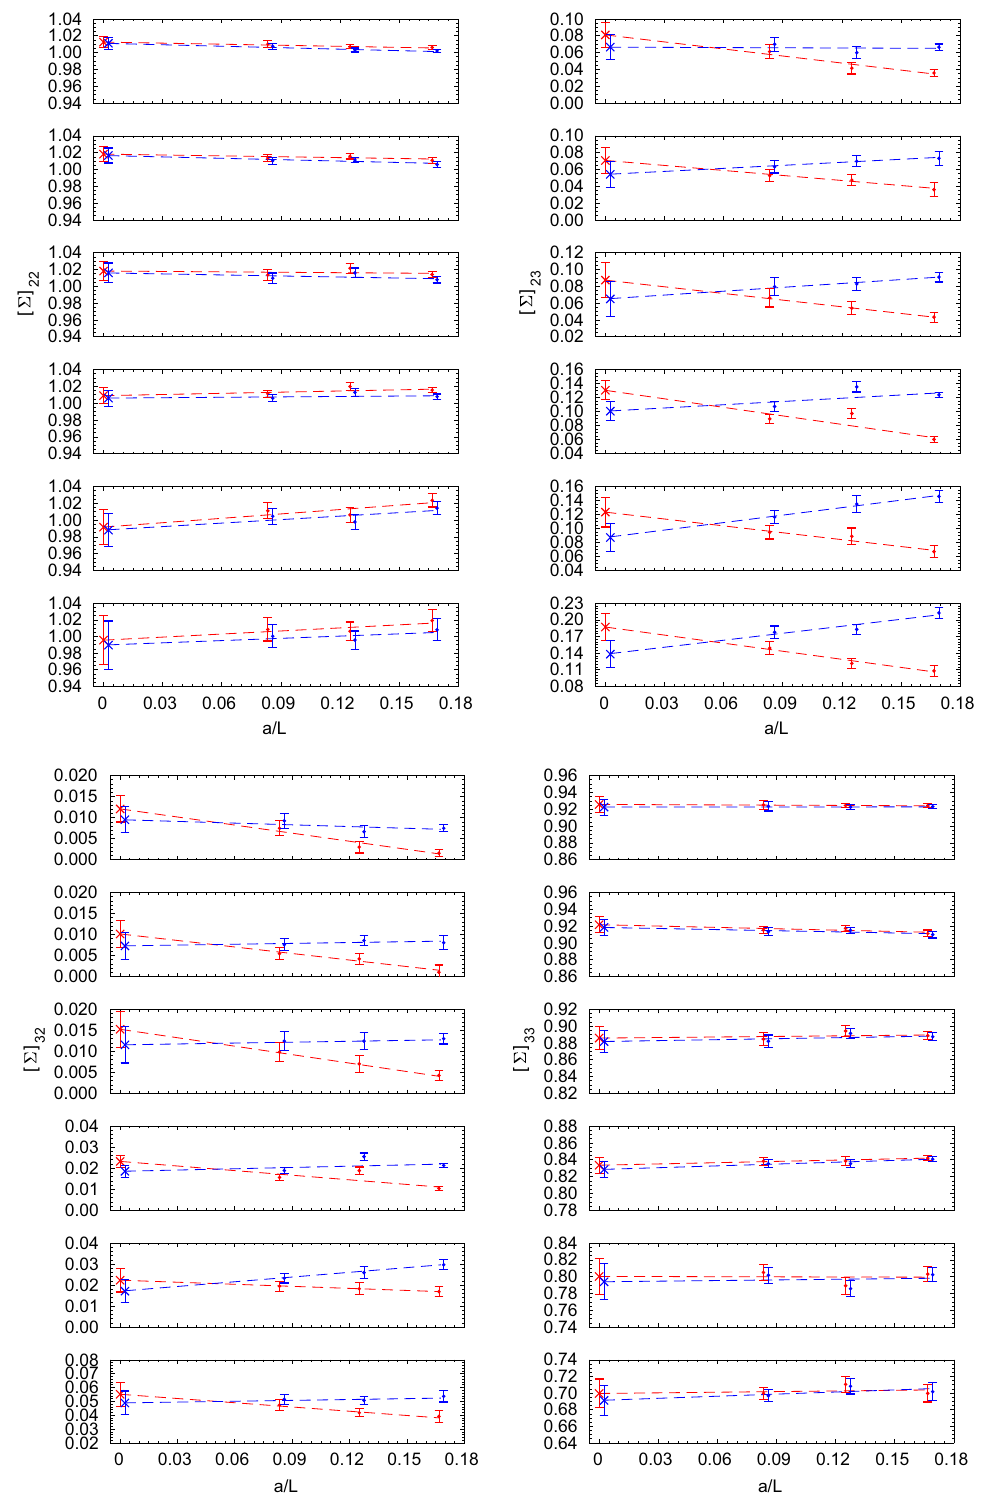
+ ( u , a / L ) inblue,oftheoperatorbasis { Q +